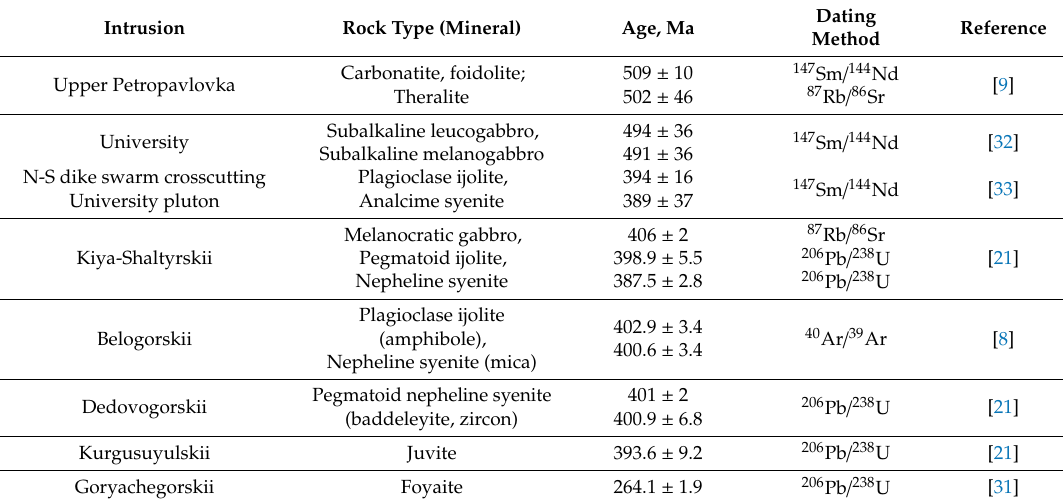
Table 2. Dating of alkaline–basic intrusions in the Kuznetsk Alatau